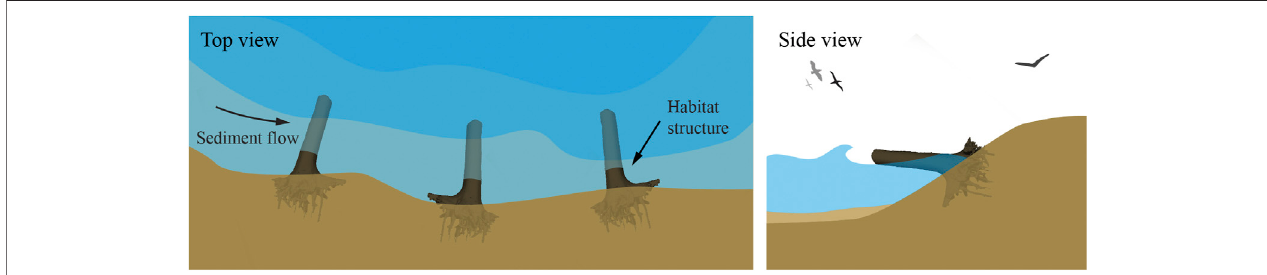
FIGURE 10 | Erosion prevention concept along a shoreline — The top view (left) shows modeled rootwads embedded along a shoreline with root fan facing landward and truncated trunk (note transparency in open water) facing seaward. The side view (right) shows one rootwad with root fan embedded along a sloped shoreline